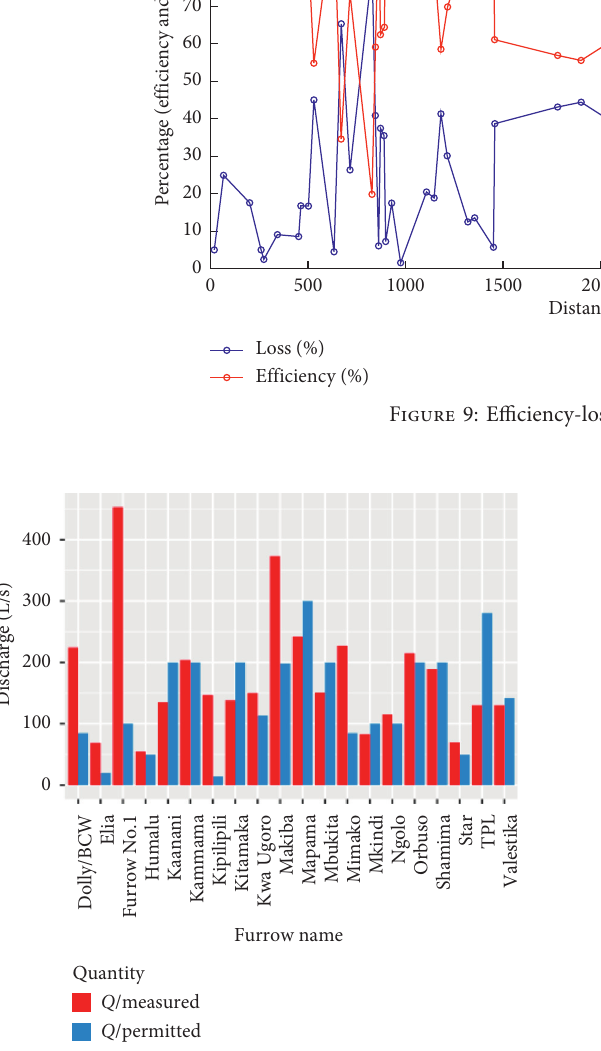
Figure 10: Quantity permitted and measured.